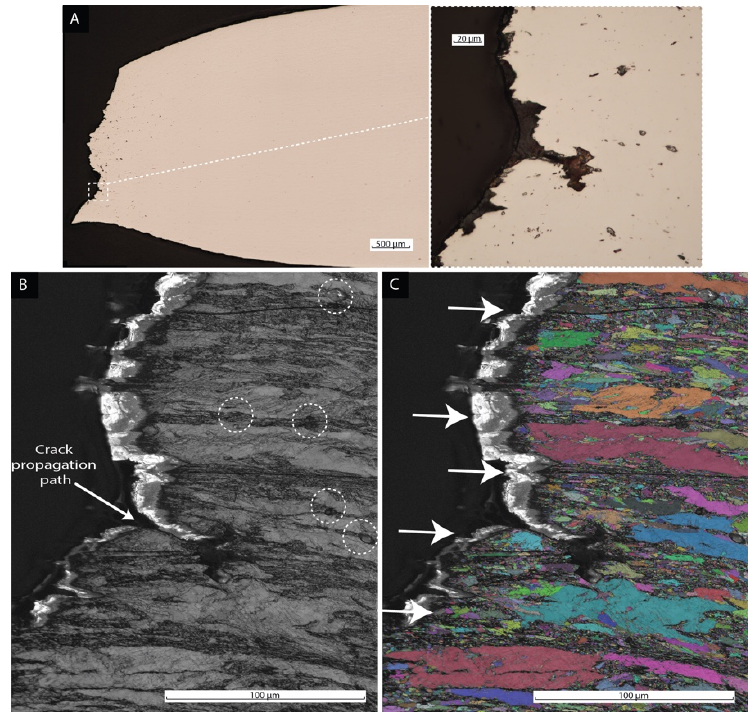
Figure 10. LOM cross-section of surface fracture from 0-wt% Ni 40.7% martensite content ( A ). Micrograph ( B ) represents an EBSD map with band contrast in which dark regions are martensite, whereas grey areas represent ferrite. An arrow indicates the crack propagation path through the martensite region, and microvoids are highlighted as dash circles. Micrograph ( C ) shows an EBSD mapping in which each grain is color coded with arrows indicating the martensitic